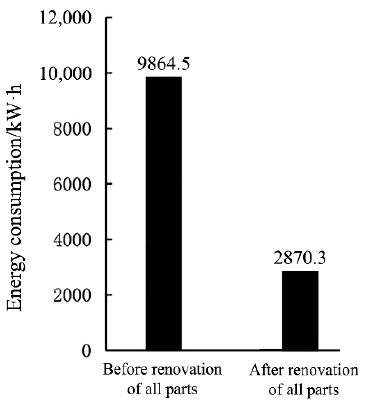
Figure 22. The simulated temperature of the master bedroom before and after renovation of all parts.